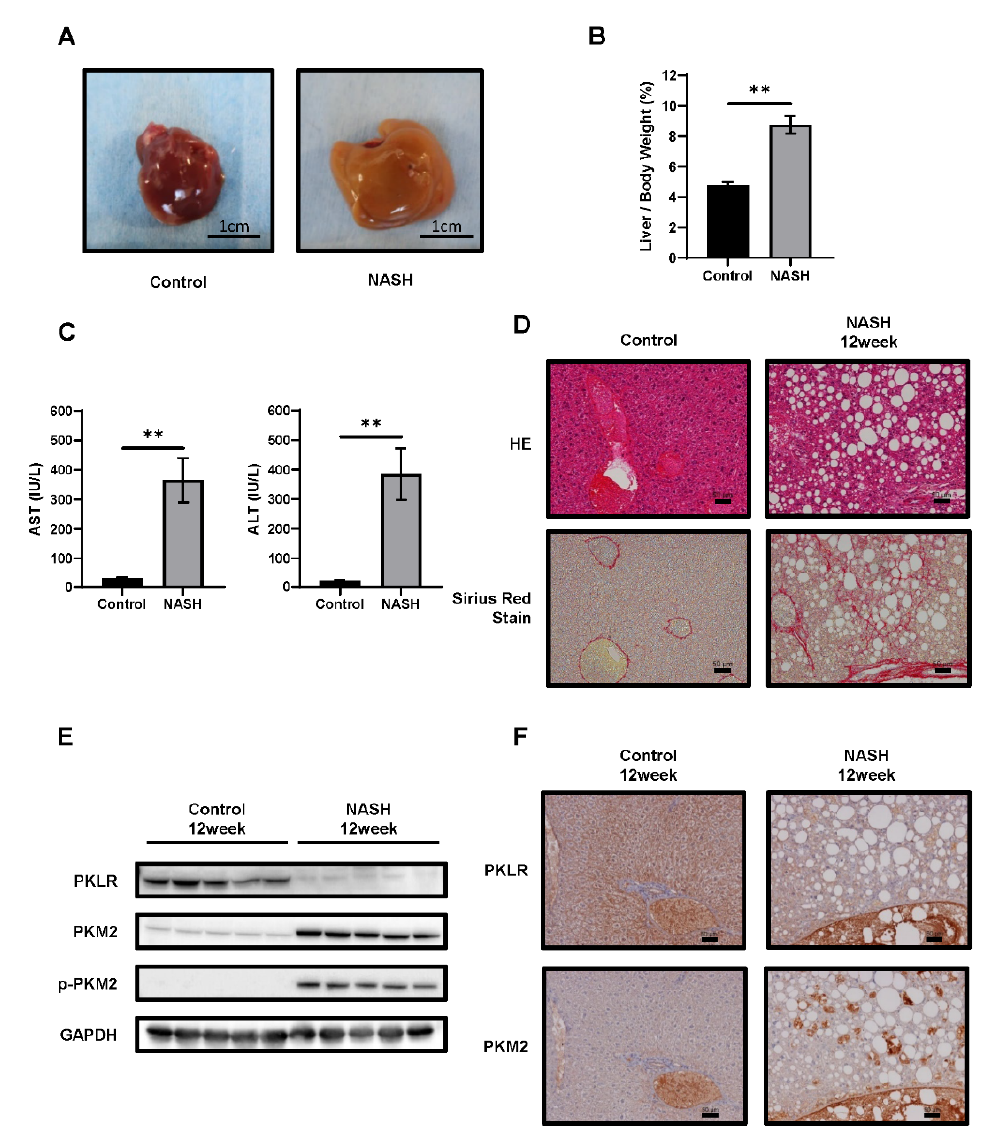
Figure 3. Comparison between C57BL/6J mice fed the standard diet (SD) or choline-deficient, L-amino-acid-defined, high-fat diet (CDAHFD) for 12 weeks. ( A ) Representative macroscopic appearance of control ( n = 5) and non-alcoholic steatohepatitis (NASH) ( n = 5) livers. Scale bars = 1 cm. ( B ) The liver-to-body weight ratio in each group. ( C ) AST and ALT levels in plasma. Values represent the mean ± SD. Note: ** p ˂ 0.01 vs. control. ( D ) HE-stained and Sirius Red-stained liver sections. Scale bars = 50 µm. ( E ) Western blotting analysis and ( F ) immunohistochemistry (IHC) of the expression levels of PKM2, phosphorylated PKM2 (p-PKM2), and PKLR. GAPDH was used as an internal control. Scale bars = 50 µm.